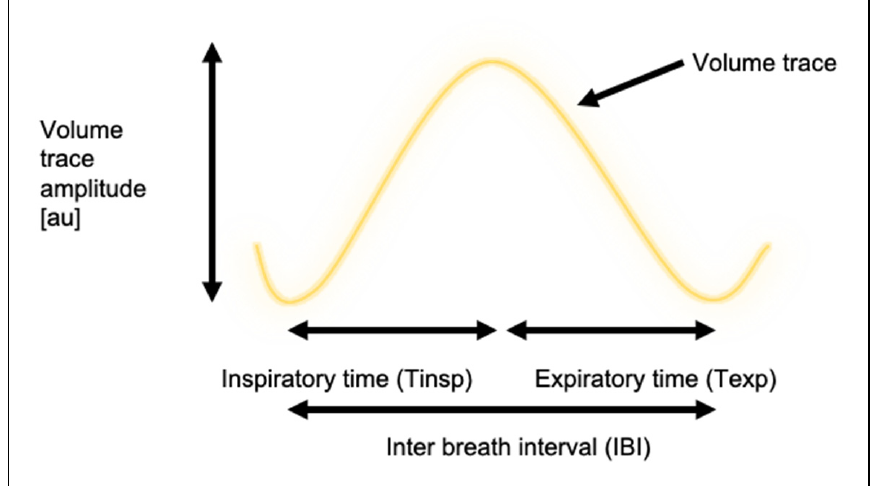
Figure 2. Diagrammatical definitions of respiratory metrics derived from a volume trace.